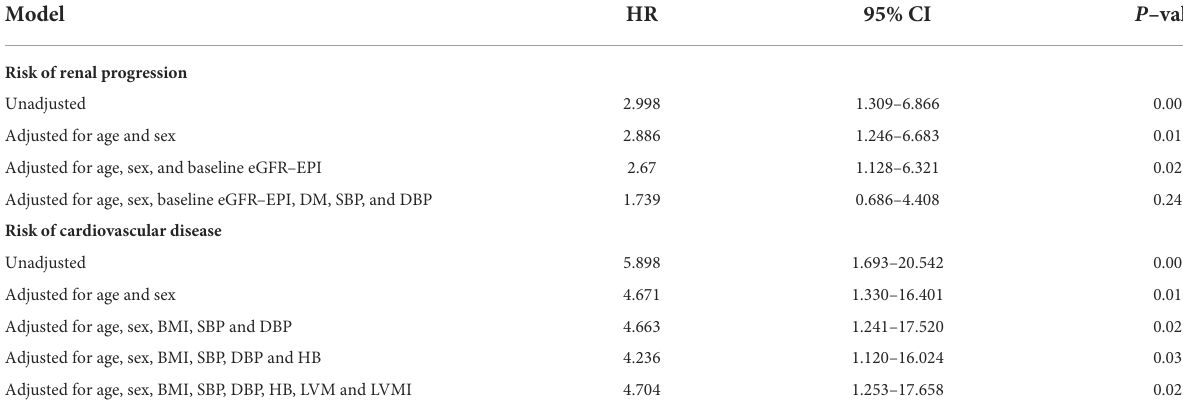
TABLE 3 Multivariate Cox proportional hazard model showing association of high SBP–VIM with renal progression and cardiovascular events. Model HR 95%